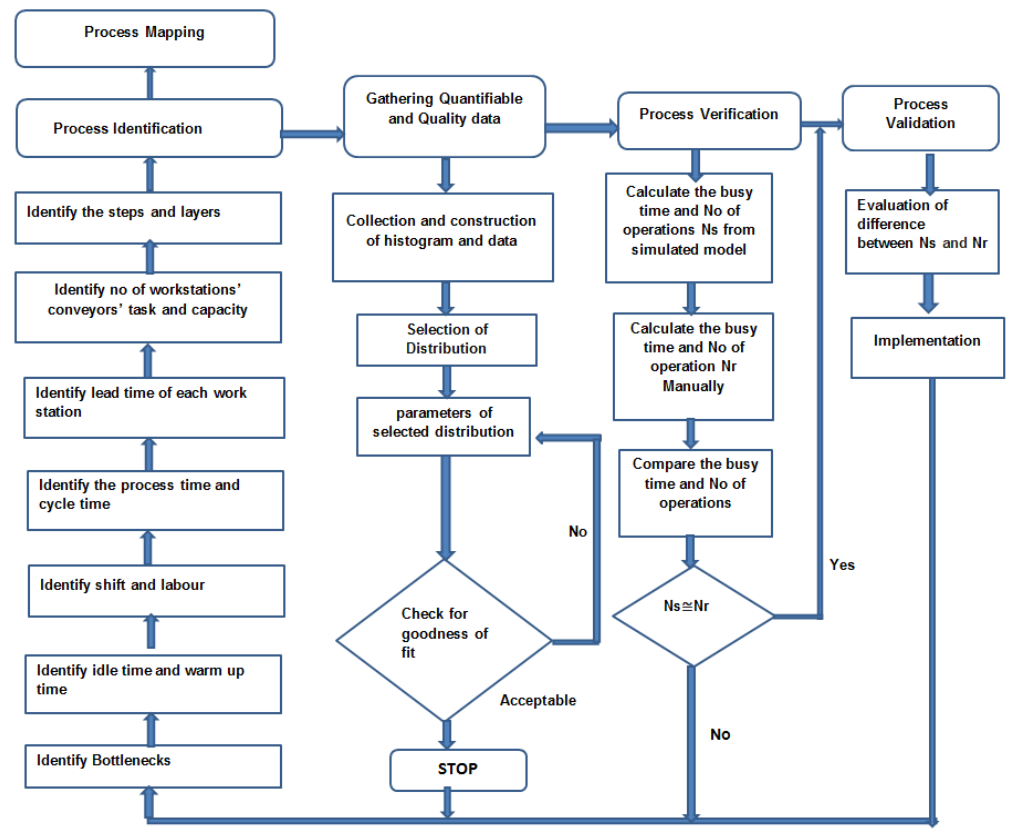
Figure 8. Data-driven process reengineering technique for the manufacturing process.